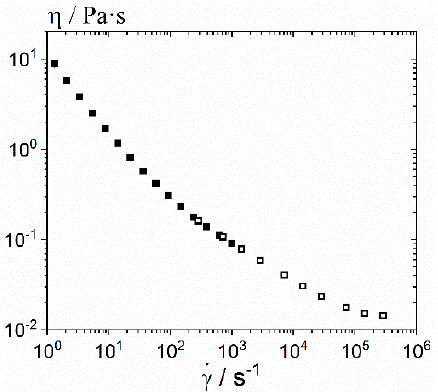
Figure 1. Shear viscosity η s as a function of shear rate γ for the automotive basecoat. Closed symbols refer to data from rotational rheometry (coaxial cylinder system DIN-Z20), open symbols correspond to capillary rheometry (radius r cap = 0.25 mm and length l cap = 40 mm of the capillary) data.